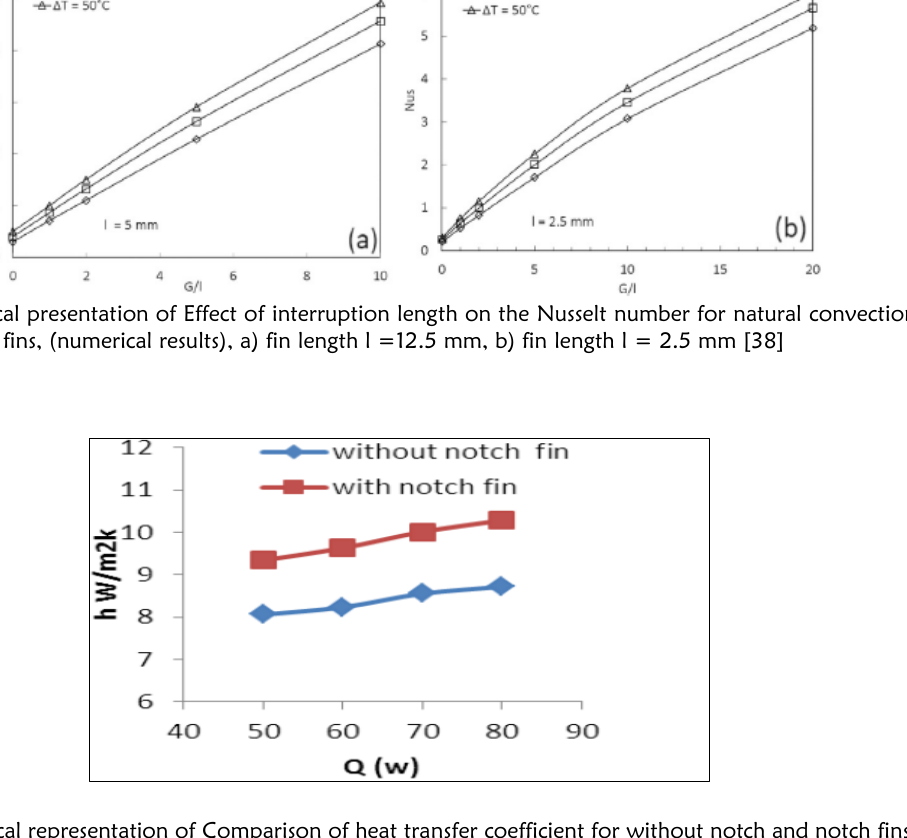
Figure 5: Graphical representation of Comparison of heat transfer coefficient for without notch and notch fins